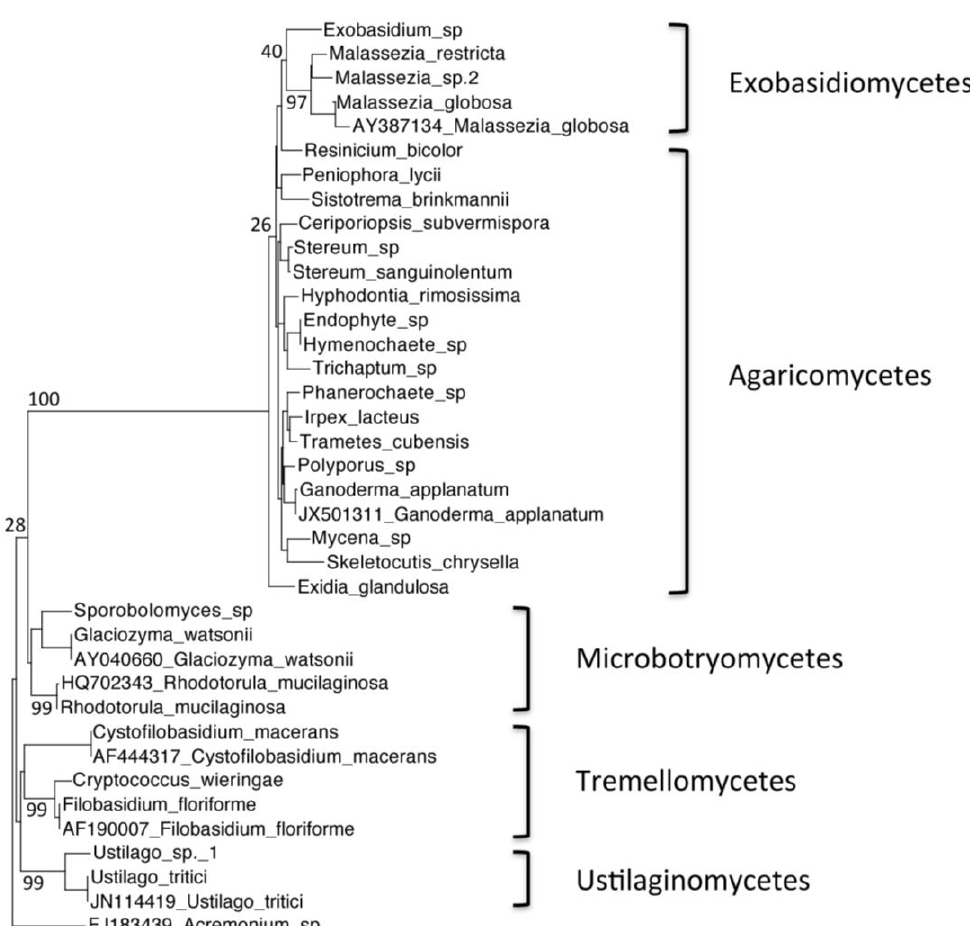
Figure 3. Phylogenetic tree of Warren Cave species belonging to the phylum Basidiomycota, obtained by neighbor-joining analysis of the Internal Transcribed Spacer (ITS) region of the 5.8S rDNA gene, with 100 full heuristic replications. Bootstrap values are as indicated on the tree. Acremonium sp. sequence obtained from GenBank was used as the outgroup, with the GenBank accession numbers listed. Ustilago tritici , Glaciozyma watsonii , Rhodotorula mucilaginosa , Ganoderma applanatum , Malassezia globosa , Cystofilobasidium macerans and Filobasidium floriforme sequences obtained from GenBank were used as closest relative reference sequences, with GenBank accession numbers